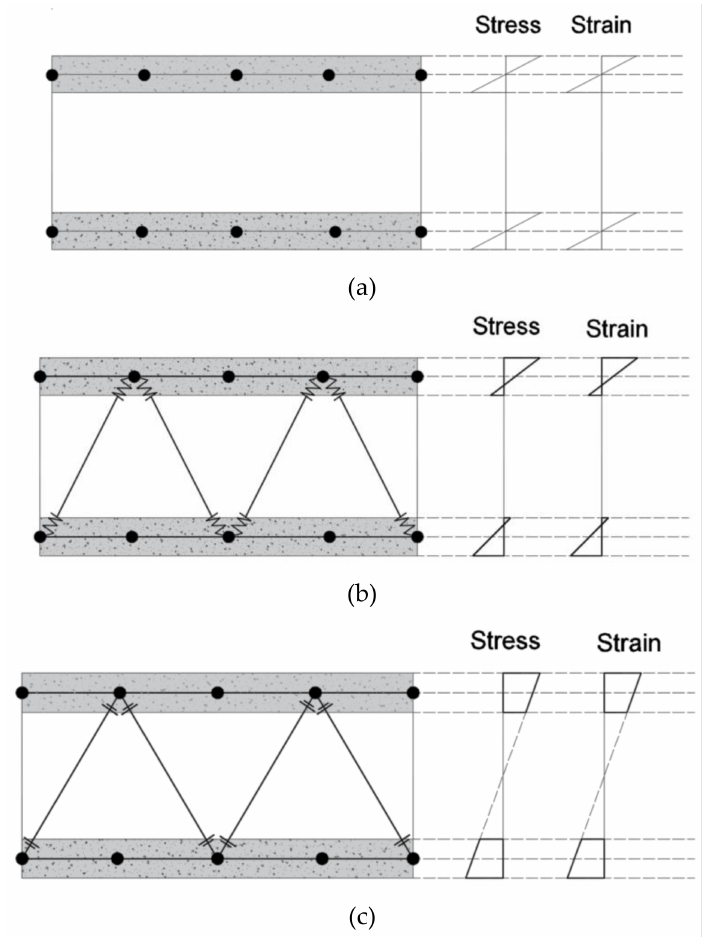
Figure 2. Different Types of Possible Composite Action in CSP Panels: ( a ) Non-Composite Action; ( b ) Partial Composite Action; ( c ) Full Composite